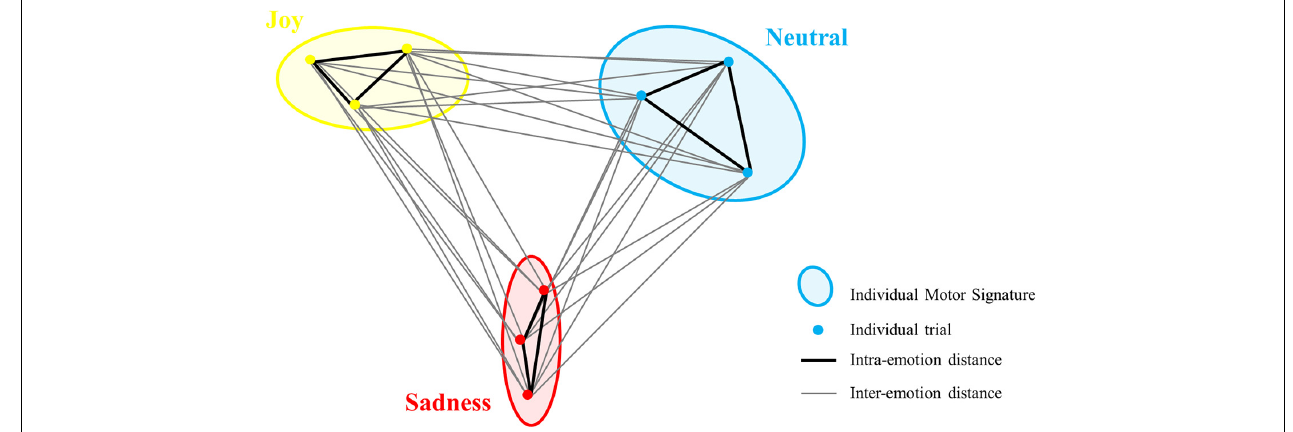
FIGURE 3 | Schematic example of ellipses of the three conditions (IMS) with intra-emotion distances (in black) and inter-emotion distances (in gray) for one participant. To compute the intra-emotion similarity index, the mean distance in black was calculated for each condition. To compute inter-emotion similarity index, the mean distance in gray was calculated between each condition. For clarity, the interaction of only three trials per condition is displayed (represented with dots), instead of nine trials in the actual experiment.